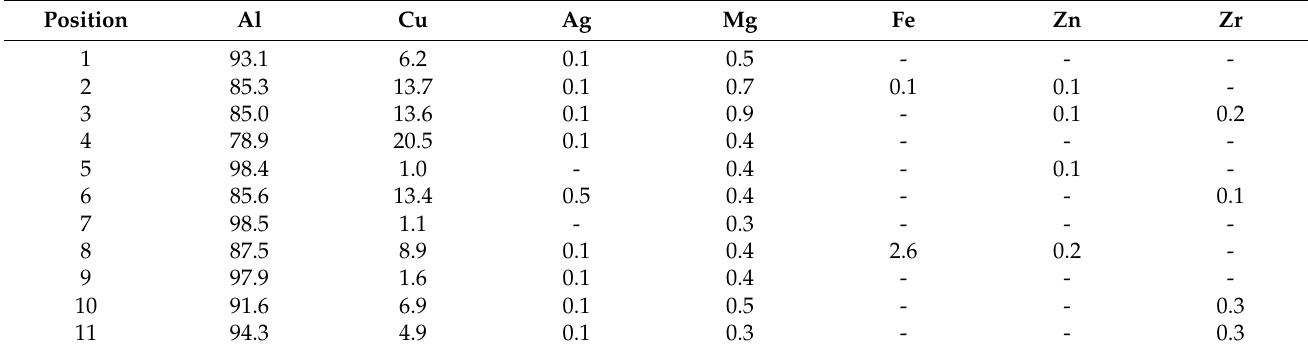
Table 2. EDS analysis (wt%) on the selected positions in Figure 9b,d.